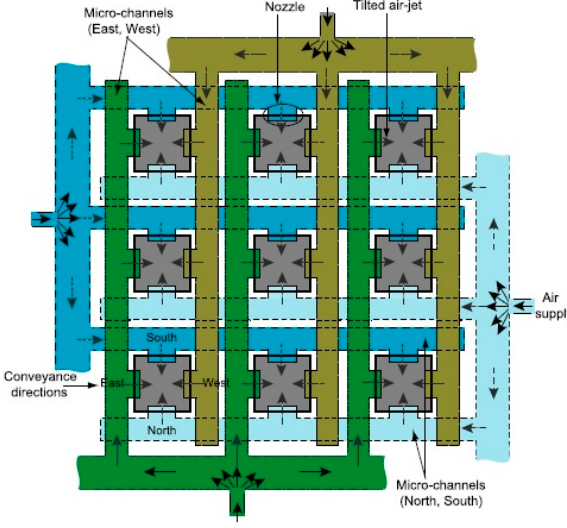
Figure 4. The system network of microchannels.